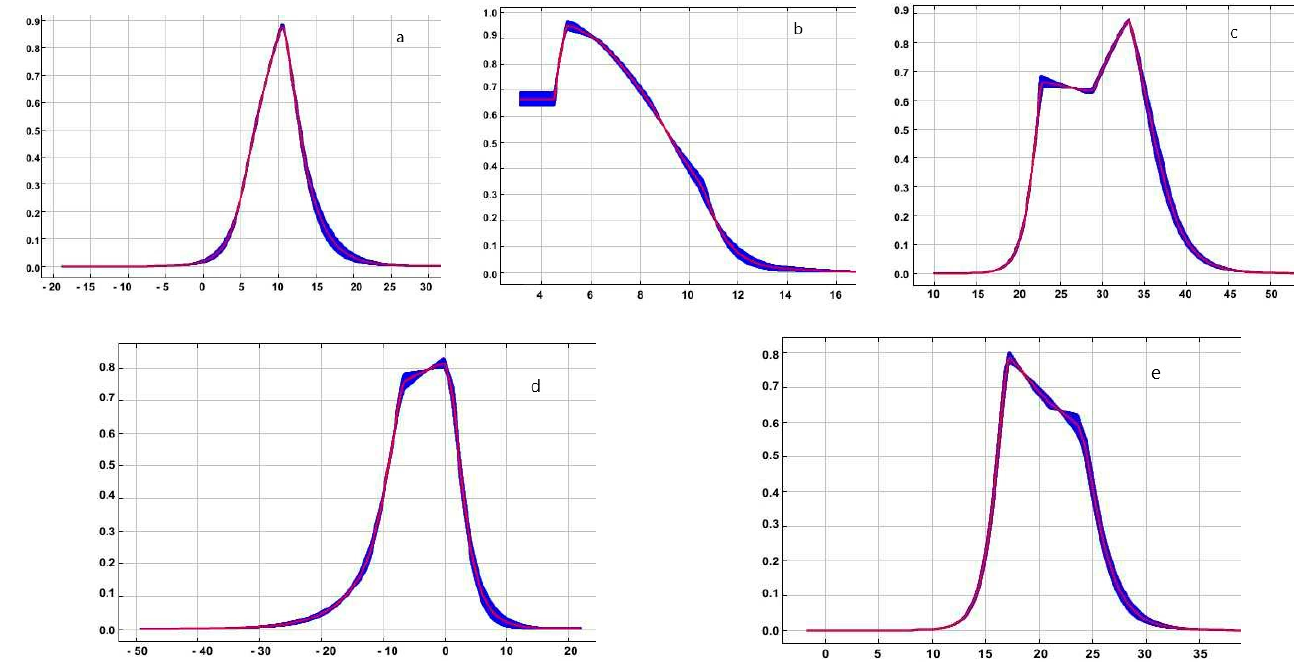
Figure 6. Response curves illustrating the relationship of predicted probability of H. rufipes occurrence to top five con- tributing environmental variations: ( a ) Mean annual temperature (bio 1); ( b ) Mean daily range of temperatures (bio 2); ( c ) Isothermality (bio 3); ( d ) Lowest temperature of coldest month (bio 6) and ( e ) Mean temperature of warmest quarter (bio 10).